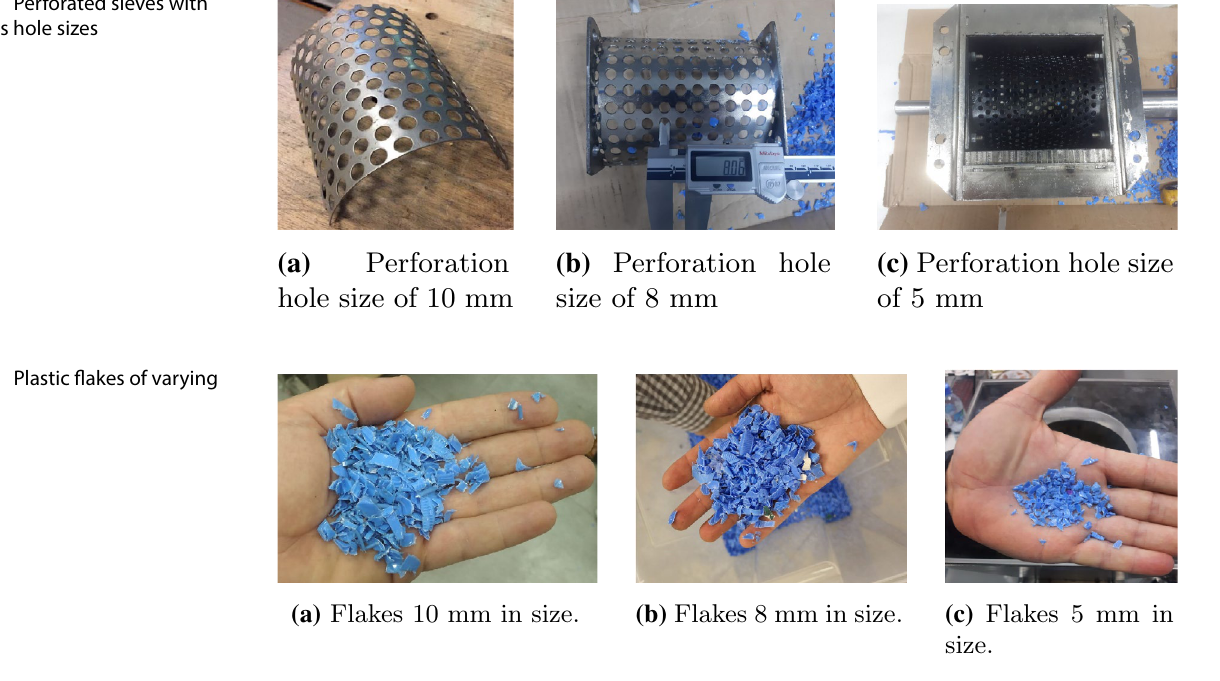
Fig. 13 Perforated sieves with various hole sizes